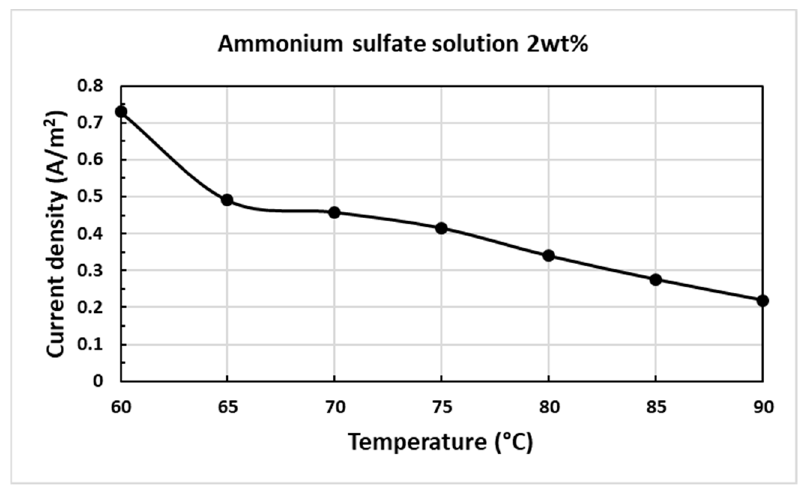
Figure 7. Supplementary curve of current-density–temperature curve resulting from the use of 2 wt% ammonium sulfate. Table 4. Measurement of current-density from 60 to 90 °C.